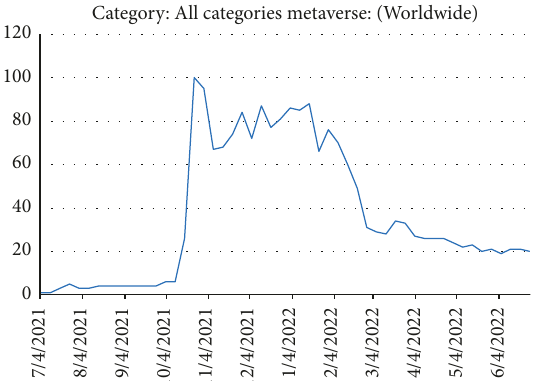
Figure 1: Graph depicting the number of “Metaverse” searches performed on Google in the last 12 months. This data has been obtained from Google Trends Data and can be found in [15]. The rapid increase in the searches can be seen in October following Facebook’s and Microsoft’s press